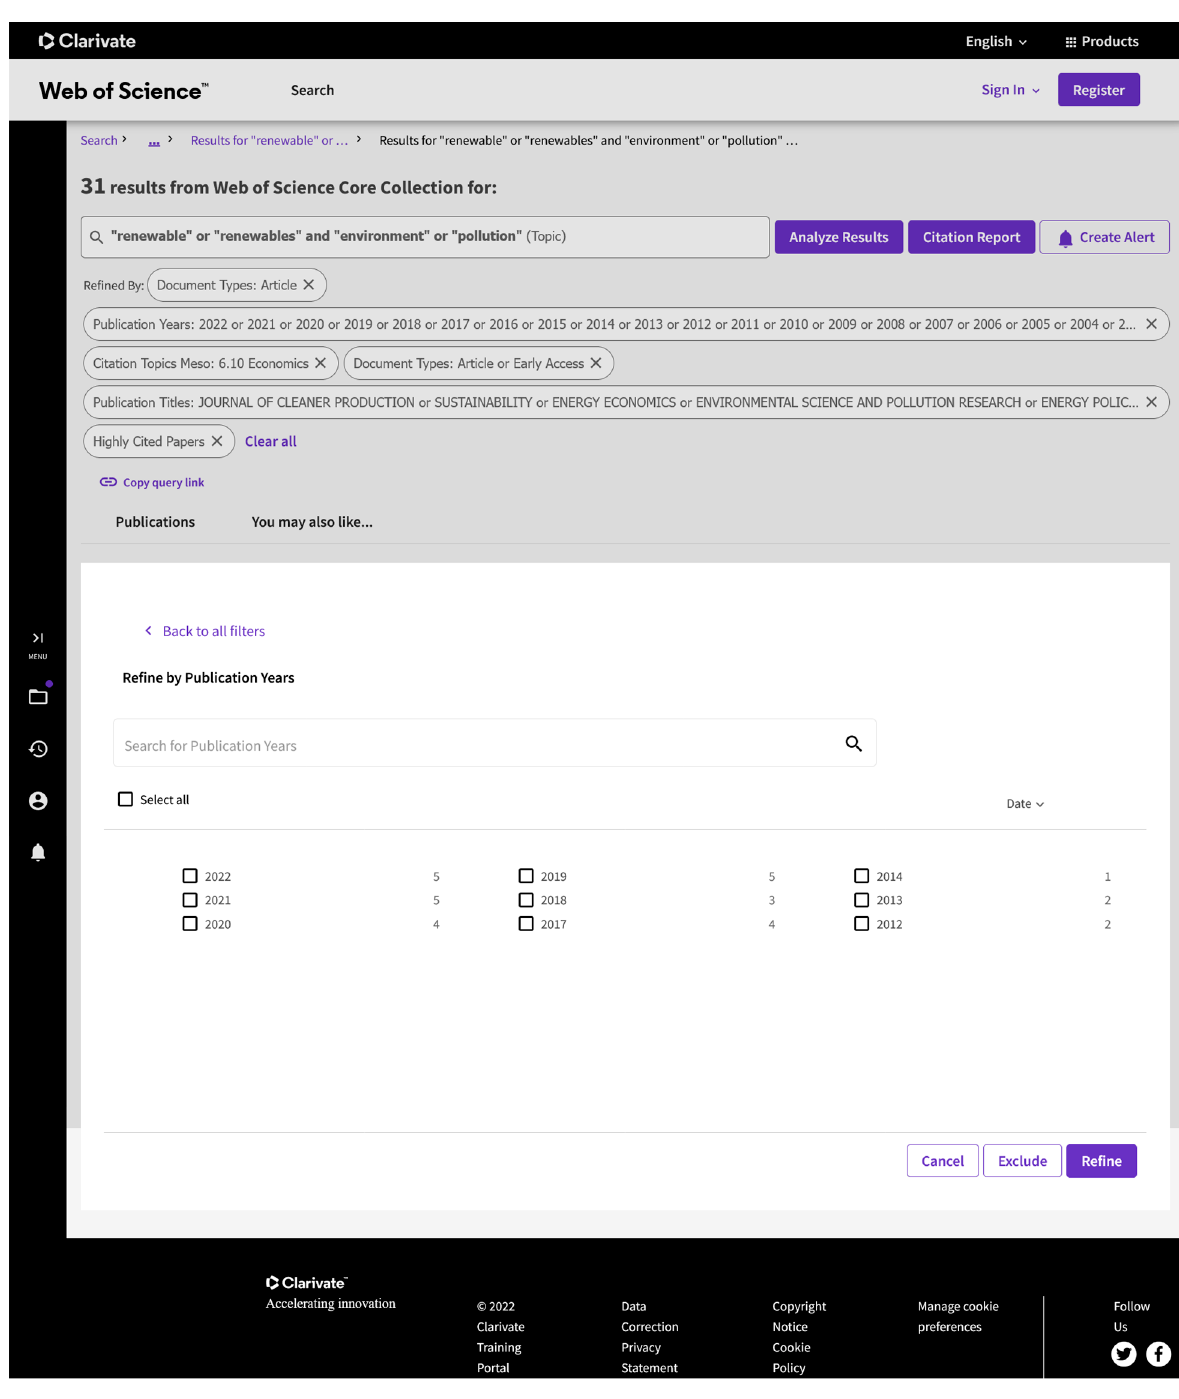
Figure A2. WOS Search—ESI Highly Cited Articles.